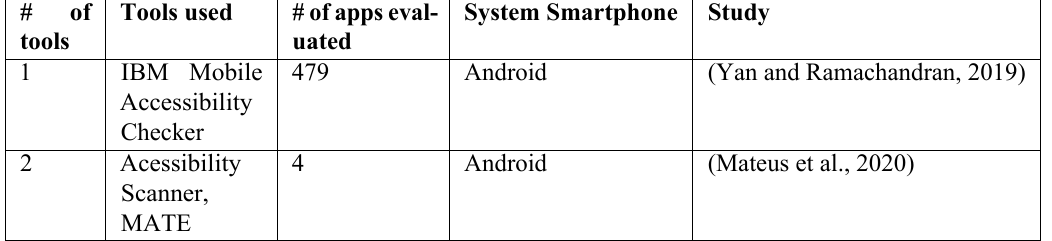
Table 3. Automated tools used in the mobile